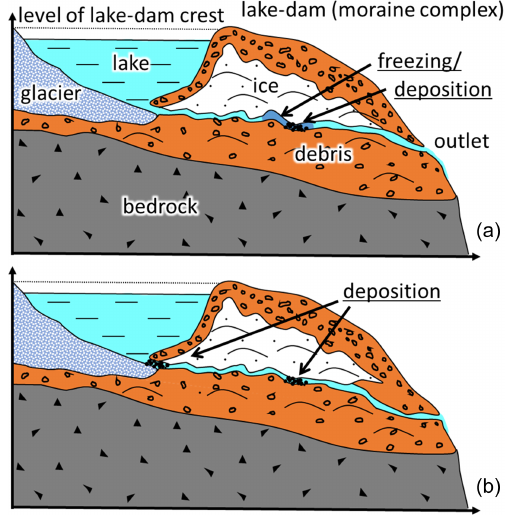
Figure 11. The two types of ice tunnel closure occurring in the northern Teskey Range. Sketches show cross sections through a glacier, lake basin, and ice-cored moraine complex in the case of a short-lived lake (based on Popov, 1987). (a) Deposition–freezing type of closure in the event of an outlet ice tunnel being blocked by freezing of storage water or deposition of debris and ice. Dark blue in the tunnel means frozen. (b) Deposition–collapse type of closure in the event of an outlet ice tunnel being blocked by deposition of debris and ice by thermal erosion (ice melt).